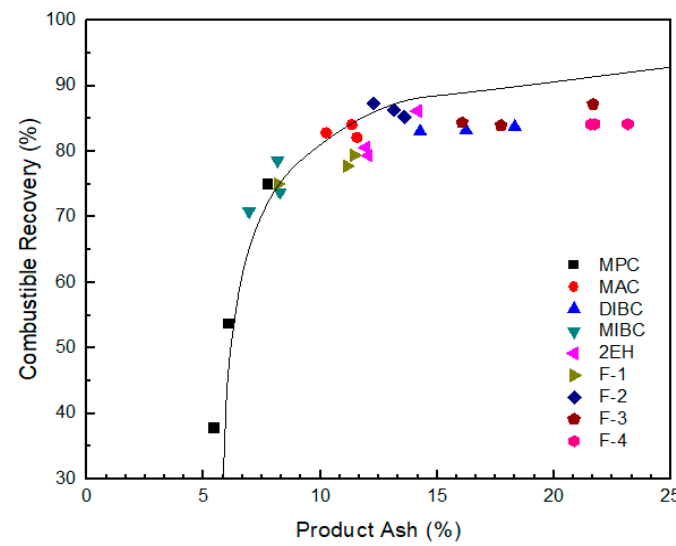
Figure 9. Combustible recovery of evaluated frothers as a function of clean coal ash; the solid line